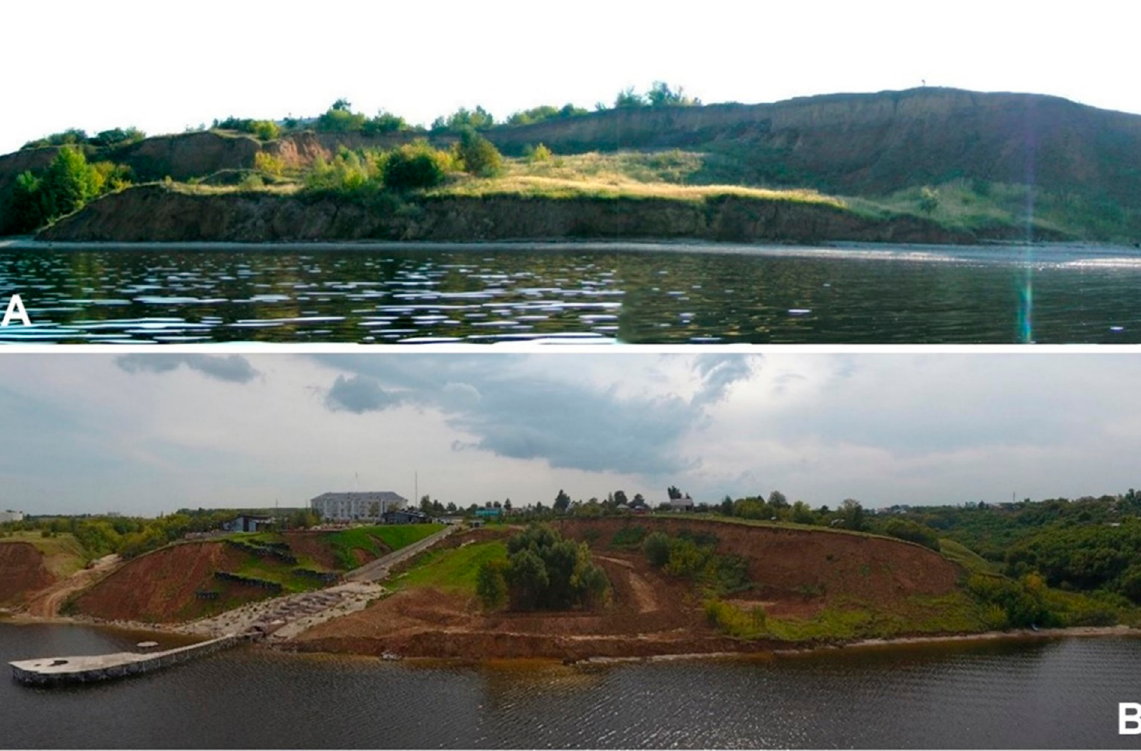
Figure 4. Views on the landslide at site 2 in 2003 (( A )—front view, ( A’ )—lateral view) and in 2019 (( B )—front view, ( B’ )— lateral view). 3. Materials and Methods Various sources of information and observation methods were combined to estimate the intensity of abrasion and landslide processes at the reservoir shores. Shoreline posi- tioning for the past periods (1958, 1985, 1987, and 1993) was obtained from archived his- torical aerial images (Kazan University Library); data for 1975, 2010, were obtained from satellite imagery interpretation. Field measurements at the study sites were conducted in 2002, 2003, 2005, and 2006 using Trimble M3 total station (2014). Since traditional methods mainly provide information about the planar displacement of the landslide scarp edge, the laser scanning method was additionally used in 2012–2014 to study the volume changes in hard-to-reach and hazardous areas. A Trimble GX TLS used as scanning equip- ment (Figure 5, Table 1). From 2019 onwards, field surveys include a DJI Phantom 4 UAV survey.